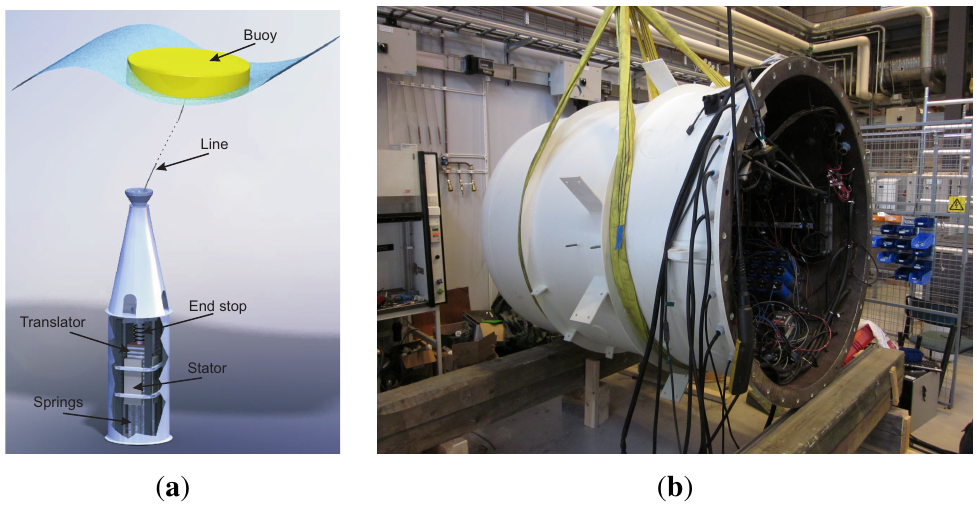
Figure 1. ( a ) WEC schematic; ( b ) Offshore marine substation.